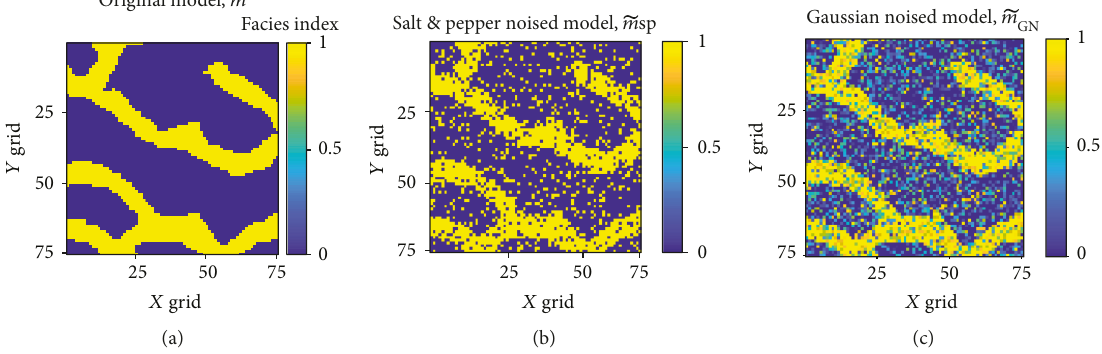
Figure 3: Three realizations of the (a) original, (b) salt and pepper noise, and (c) Gaussian noise reservoir models.